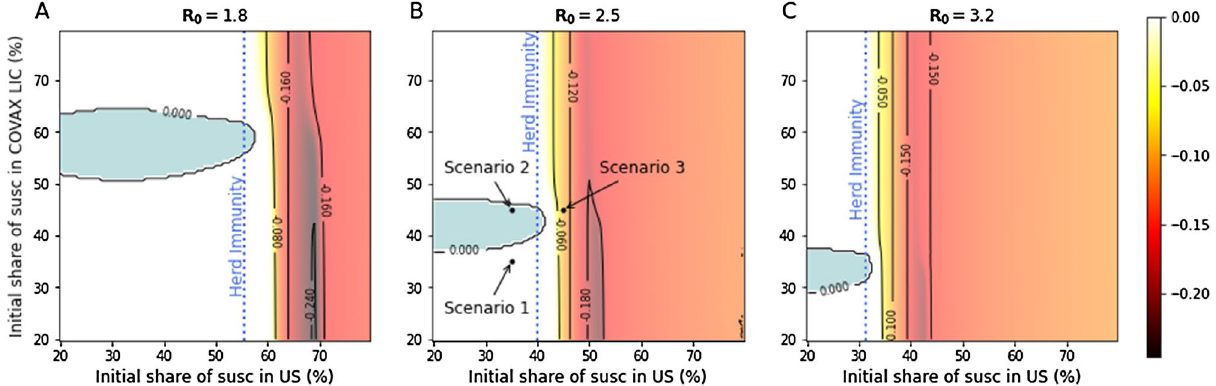
Figure 3. Share of individuals reached by the infection in the US, difference between uncooperative and cooperative scenarios. Difference between the share of infected in the US after 60 mln extra doses are distributed in the US (uncooperative scenario) and the share of infected in the US after the same number of doses is distributed in COVAX-LIC (cooperative scenario) for different values of R 0 and susceptibility levels. Positive numbers (in blue) indicate a lower share of infected in the cooperative scenario. The shares of infected in the US are estimated using a SIR compartmental model and consider the whole evolution of contagions over the time span of 10 years. As initial condition, at time 0 we set the number of infected individuals equal to 1000 in COVAX-LIC and 0 everywhere else. ( A ) Difference in shares of infected, under the assumption that R 0 = 1.8. ( B ) As ( A ), but assuming R 0 = 2.5. ( C ) As ( A ), but assuming R 0 = 3.2. Each point corresponds to a different combination of share of susceptible at time 0 in the USA and in the COVAX-LIC. In ( B ), Scenario 1 to 3 refer to panels ( A ) to ( C ) in Fig.